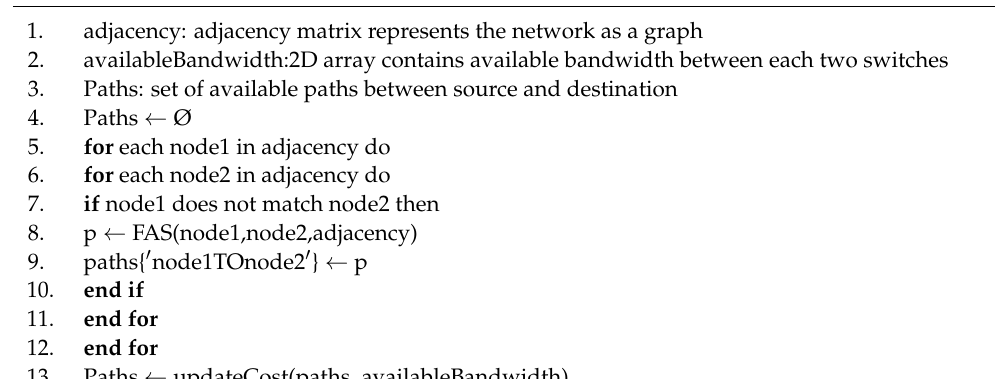
Algorithm 3 Find all Available Paths Between each pair of Switches